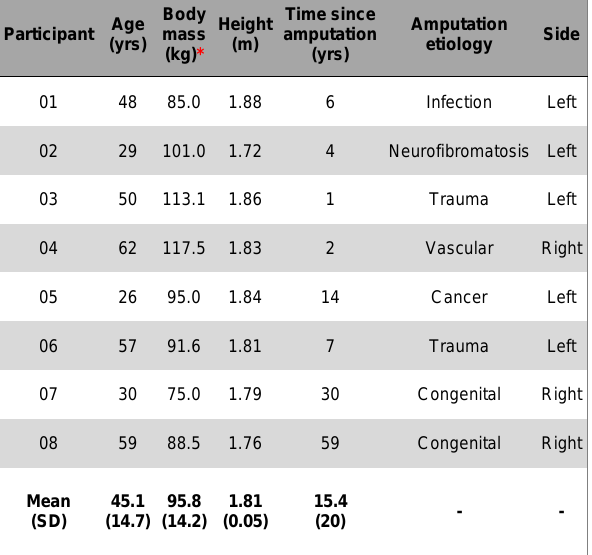
Table 1 : Participant demographics and clinical characteristics. Body Height Participant Age mass (yrs) (m) (kg)*